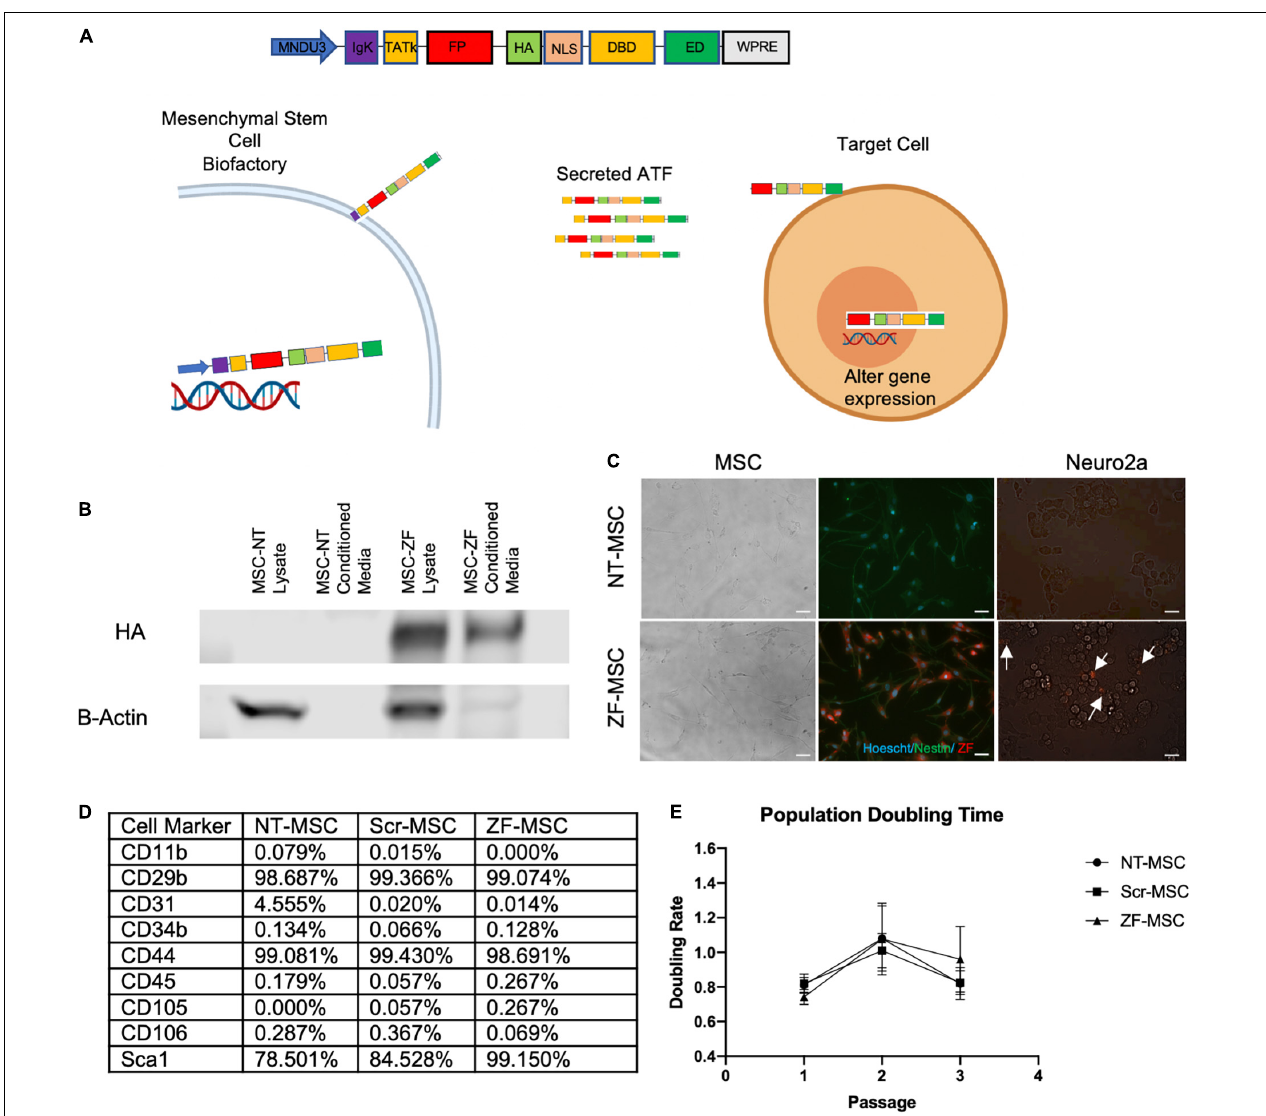
FIGURE 1 | Engineered MSC can function as biofactories for zinc finger (ZF). (A) Schematic of design of secreted protein. Injected MSC biofactories secrete ZFs via the IgK Leader Signal Peptide into the extracellular space whereby these proteins are taken up by neighboring cells by the TATk element. ZFs are trafficked into the nucleus of target cells via NLS-tagged transport to alter target cell gene expression. (B) Western blot depicting presence of HA-tagged secreted ZF in conditioned media of MSC 48-h following serum starvation. (C) Left Panel: Fluorescent microscopy depicting Hoechst-labeled MSCs (blue) transduced to express ZF (red). Right Panel: Fluorescent microscopy depicting co-localization of ZF (red) on recipient Neuro2As following a 24-h incubation with conditioned media from ZF-MSCs. White arrows indicate Neuro2A that co-localize with ZF. Scale bar = 100 µ m. (D) Table summary of FACS detailing the enrichment of isolated and transduced MSCs for typical MSC markers and negative for markers of cells of hemopoietic origin, related to Supplementary Figures 2, 3 . (E) MSCs were passaged every 2 days and cell counts were recorded prior to plating. Transduction of MSCs to secrete either a Scr ZF or ZF did not demonstrate altered population doubling times compared to an isogenic NT-MSC. Error bars indicate ± standard error of the mean. Dots indicate average mean of four biological replicates. Two-Way ANOVA followed by a Tukey’s HSD. MNDU3, endogenous promoter; IgK, secretion peptide; TATk, furin-resistant TAT peptide; FPR, fluorescent protein reporter; HA, hemagglutinin epitope; NLS, nuclear localization signal; DBD, DNA-binding domain; ED, effector domain; WPRE, woodchuck hepatitis virus post-transcriptional element; ZF-MSC, MSCs that have been transduced to secrete ZF; NT-MSC, non-transduced MSC.